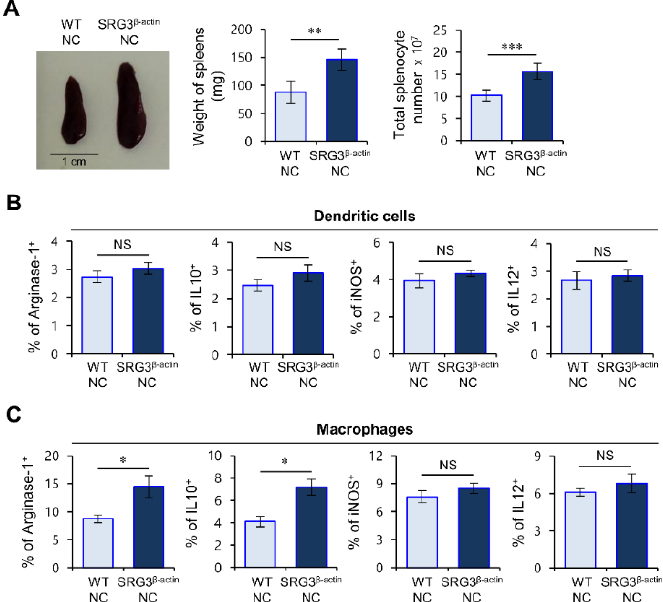
Figure 2. Elevated levels of type 2 phenotype macrophages but not dendritic cells (DCs) correlate with severe skin inflammation in SRG3 β-actin mice. ( A – C ) SRG3 β-actin NC and WT littermate NC mice maintained under barrier conditions were moved to conventional housing conditions at 6 weeks of age to develop AD spontaneously. Splenocytes were prepared from these mice at 14 weeks of age. ( A ) ( Left ), a representative picture of the spleens from AD-induced SRG3 β-actin NC and WT littermate NC mice. ( Middle ) and ( Right ), Spleen weight and splenocyte number of these mice. ( B , C ) Intracellular arginase-1, interleukin 10 (IL10), inducible nitric oxide synthase (iNOS), and IL12 production were analyzed in DCs (CD11c + ) ( B ) and macrophages (CD11b + F4/80 + CD11c - ) ( C ). The mean values ± SD ( n = 5; per group in the experiment; Student’s t -test; * p < 0.05, ** p < 0.01, *** p < 0.001) are shown. One representative experiment of two experiments is shown. NS: no significant.